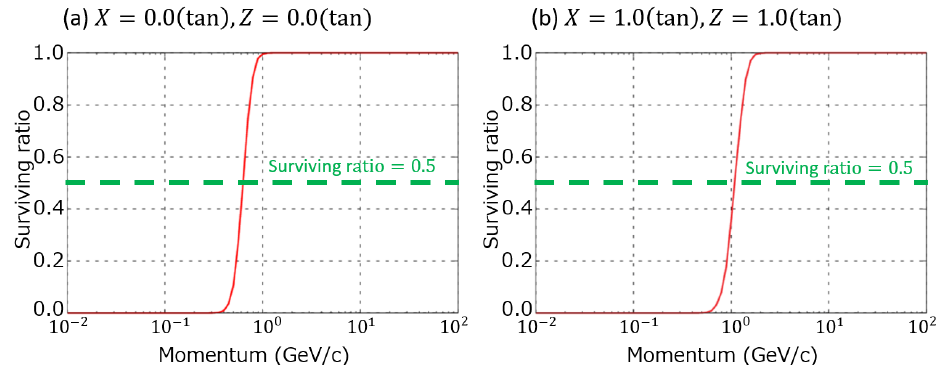
Figure 9. Survival ratio of muons after the straightness cut-off as a function of momentum. (a) Track angles with tan ( relative azimuth ) = 0 . 0 and tan ( elevation angle ) = 0 . 0. (b) Track angles with tan ( relative azimuth ) = 1 . 0 and tan ( elevation angle ) = 1 . 0. The path length in the lead plates becomes longer when the track has a larger slope, and thus the remaining momentum also becomes higher for the latter case. The momentum values at a survival ratio of 0.5 are 0.6 and 1.1GeV / c, respectively.